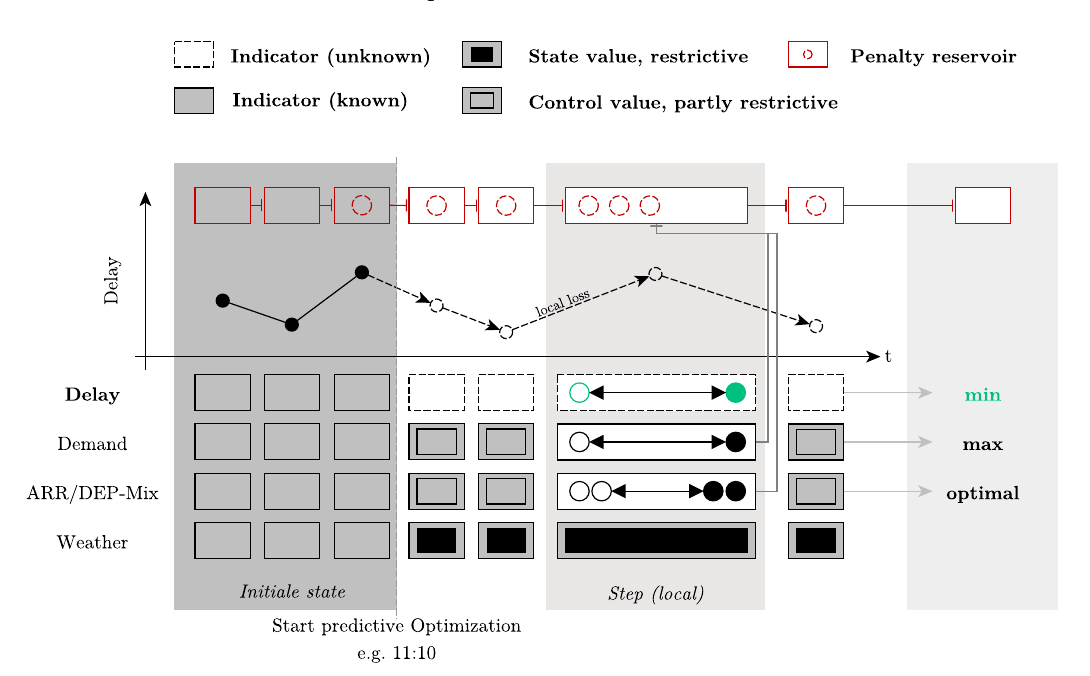
Figure 14. Overview of a global PSO to minimize delay using iteratively local PSO, which can partially induce local losses, to globally solve the optimization